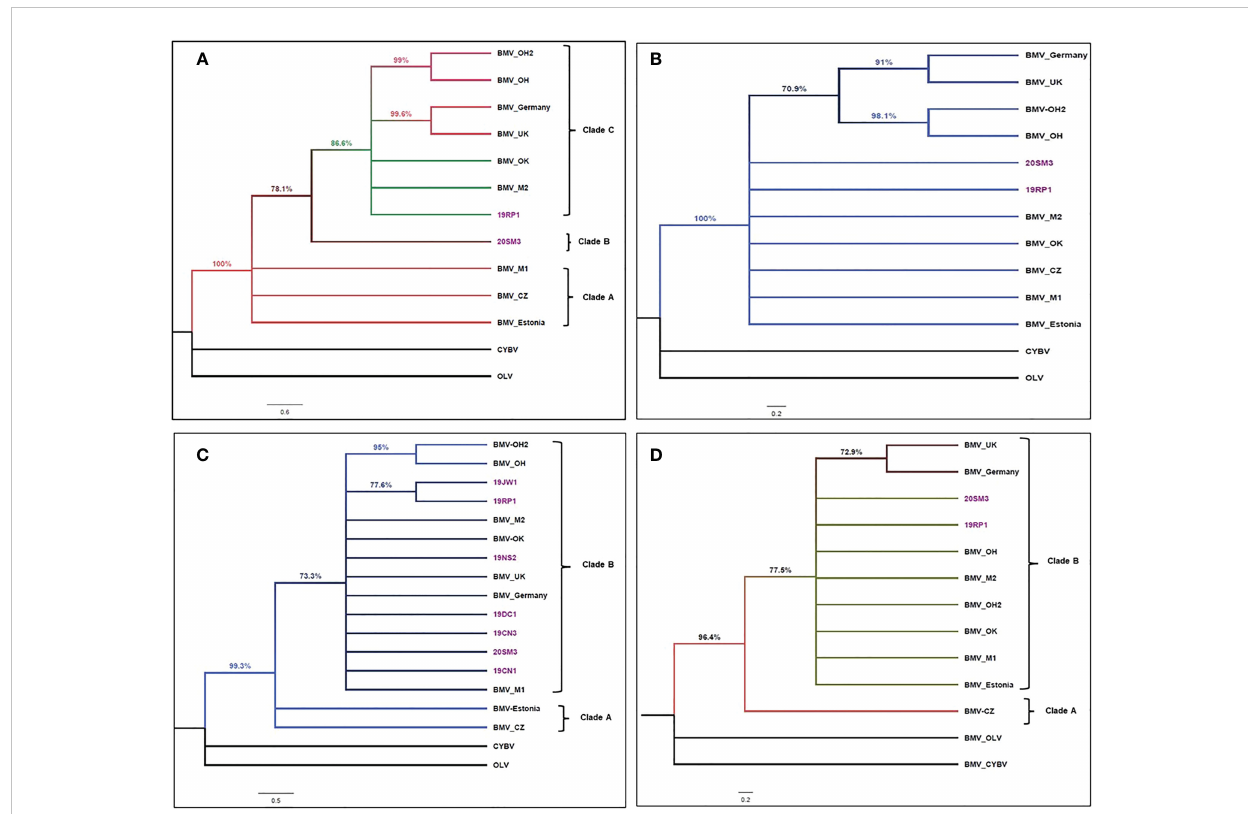
FIGURE 4 Cladogram of brome mosaic virus isolates. (A) . Cladogram of brome mosaic virus (BMV) isolates based on the coding sequence alignment of RNA1a sequenced in this study (highlighted in purple text) and selected strains retrieved from GenBank. The phylogenetic tree was made using the maximum likelihood analysis with a TN93 + G substitution model conducted in MEGA X (Kumar et al., 2018). The tree with the highest log likelihood (-11086.86) is shown. The percentage of replicate trees in which the associated taxa clustered together based on 1000 bootstrap replicates is presented. The posterior probability of 70% was the cutoff value and branches not supported were collapsed. Cassia yellow blotch virus (CYBV) and Olive latent virus2 (OLV) were used as outgroups in the analysis. Brackets on the right side indicate the taxa clustered in BMV clades A to C (B)